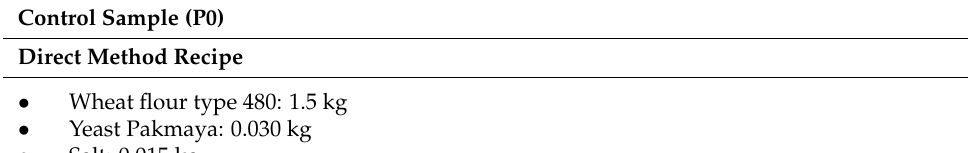
Table 3. The technological process and the final recipe for obtaining the control sample P0. Control Sample